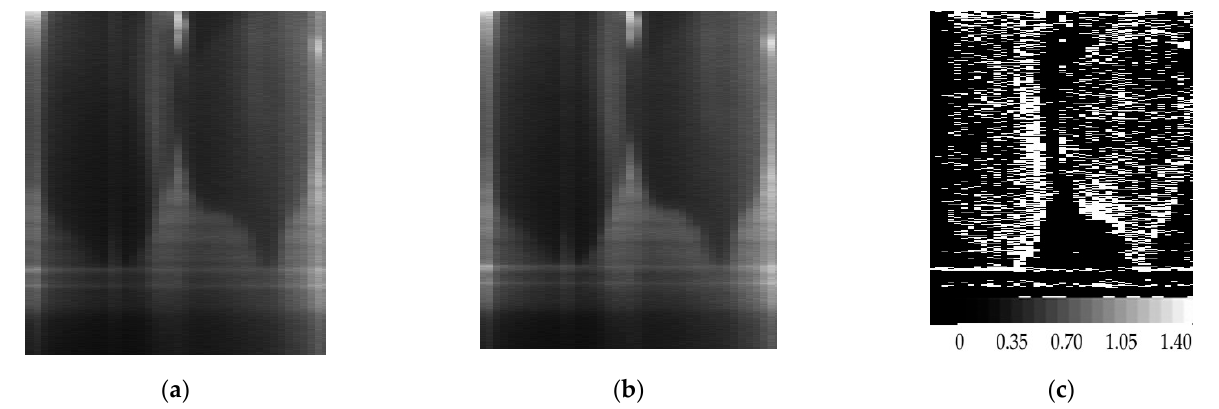
Figure 13. SDL-aided images of elm leaves at wavelengths of ( a ) 900 nm, ( b ) 970 nm, and ( c ) a water band index image of elm leaves.